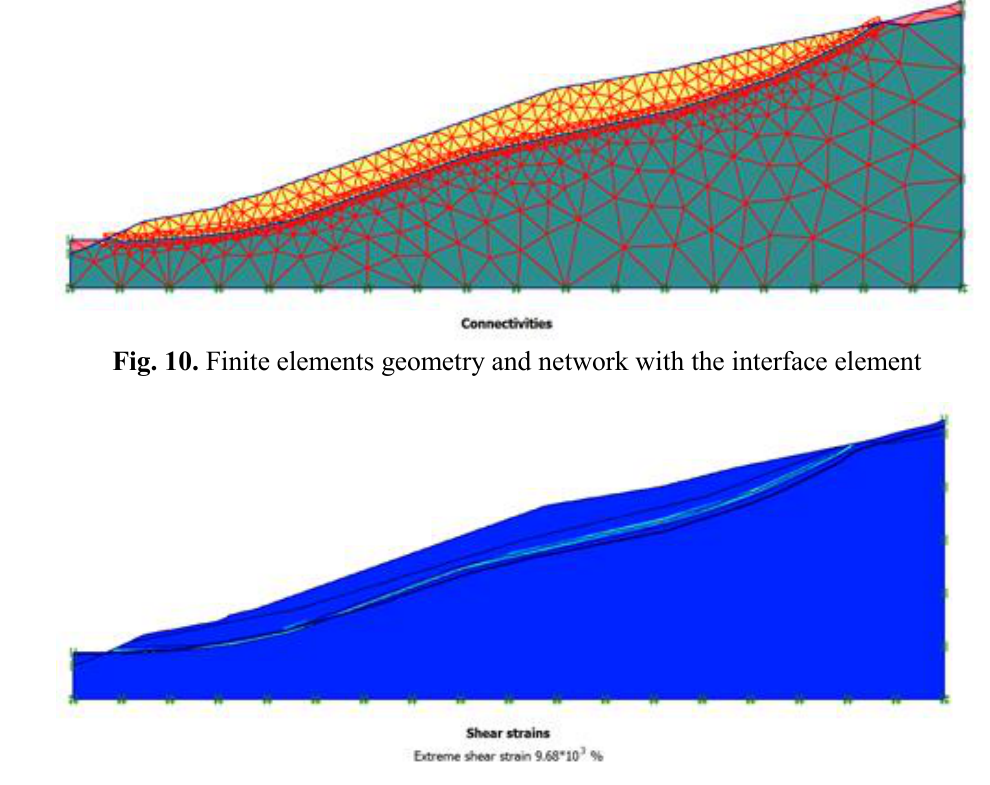
Fig. 11. Shear resistance contour of the slope to determine the sliding safety factor on